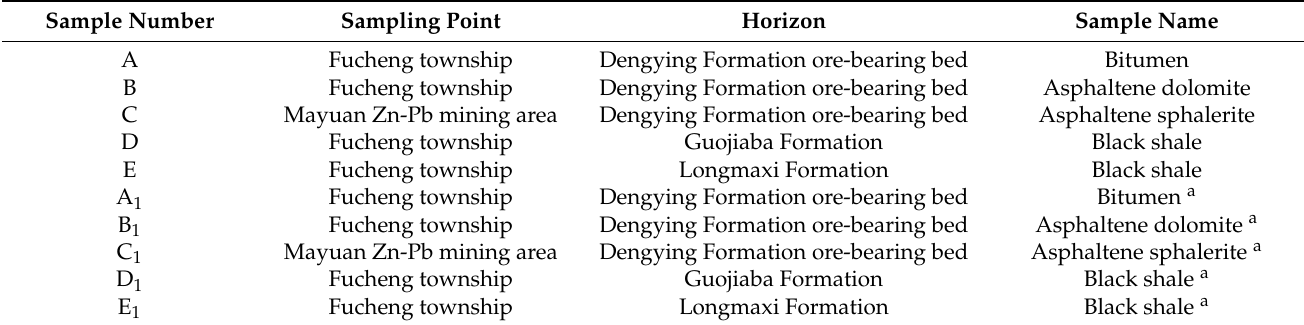
Table 1. Sample number table in the study area.